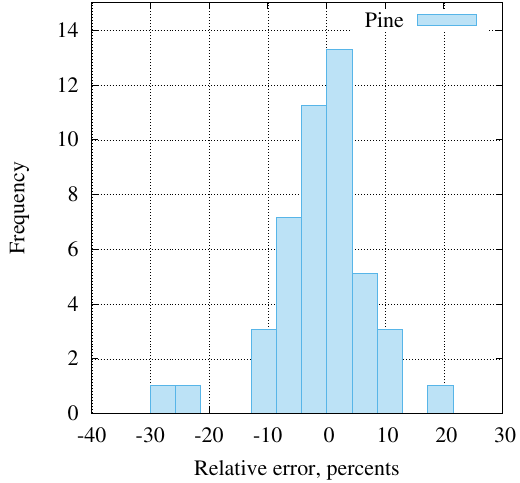
Figure 6. Relative errors of simulated spectra, pine